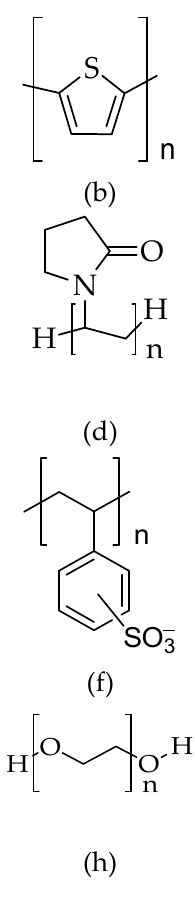
Figure 14. Chemical structure of the polymers used in the development of NH 3 hybrid nanocomposite sensors: ( a ) polypyrrole (Ppy); ( b ) polythiophene (PTh); ( c ) polyaniline (PANI); ( d ) polyvinylpyrroli- done (PVP); ( e ) poly(3,4-diethylenedioxythiophene (PEDOT); ( f ) poly(styrene sulfonate) (PSS); ( g ) polyvinylidene fluoride (PVDF); ( h ) polyethylene glycol